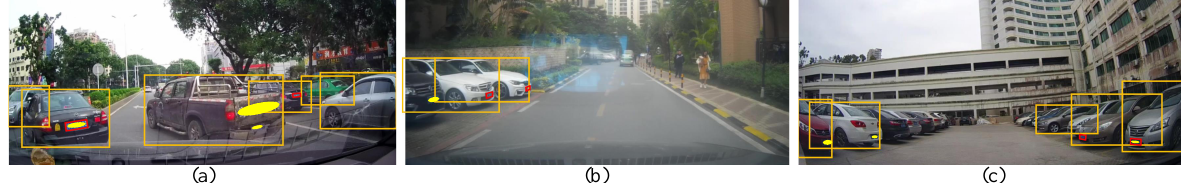
Figure 10. Failed examples. The orange rectangle represents the horizontal bounding box of the vehicle. The red quadrangle indicates the quadrilateral bounding box of the license plate. ( a ) Failed due to various illuminations. ( b ) Failed due to vehicle occlusion or boundary truncation. ( c ) Failed due to various orientations. All the recognizable license plates are manually covered with a yellow ellipsoid to protect